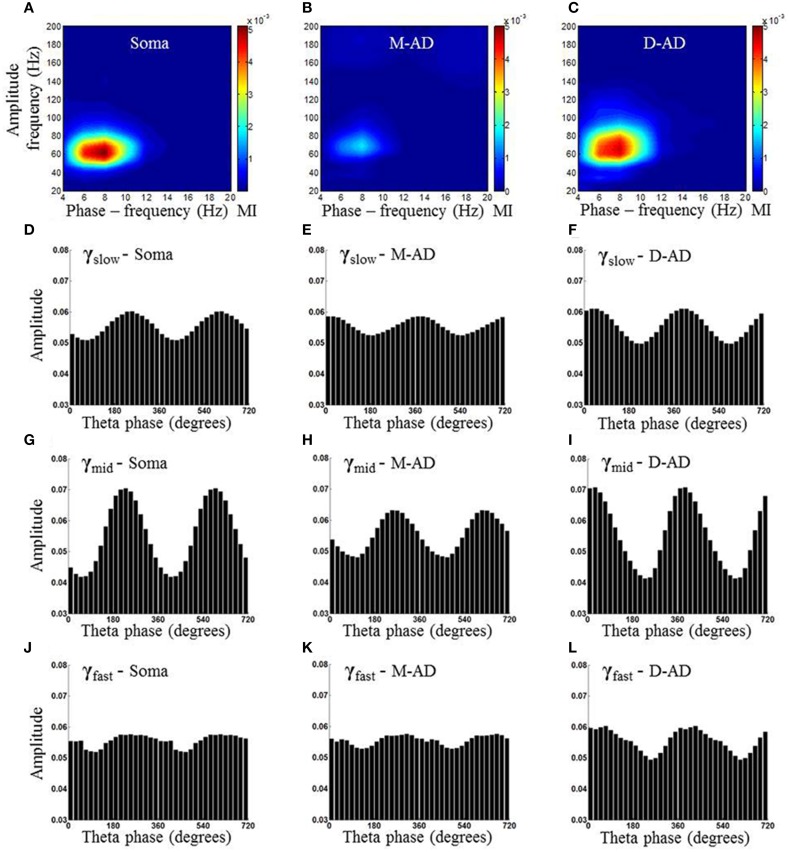
Example of comodulogram and phase amplitude coupling at somatic, mid-apical and distal apical dendrite recording sites, for a single animal. (A–C) Comodulogram showing the modulation Index (MI) plotted as a function of phase-frequency and amplitude-frequency from a single animal. Hotter colors indicate larger amplitude modulation. (D,G,J) γslow (30–45 Hz)/γmid(50–90 Hz) /γfast (90–170 Hz) amplitude modulation by θ (6–10 Hz) phase, binned into 18 subdivisions of 20° each at the somatic recording site. (E,H,K) The γslow, γmid, and γfast amplitudes from the recording site at the mid-apical dendrite (M-AD) shows relative amplitude modulation by θ similar to that seen at the somatic site; however the phase of θ at which gamma amplitude was maximum were offset by 120° for γslow and 20° for γmid. (F,I,L) At the distal apical dendrite (D-AD) the amplitude coupling was anti-phasic (offset by 180°) for γslow and γmid with respect to soma. In addition the θ-γfast coupling was visible primarily only at D-AD [Phase amplitude coupling measurements shown in this figure were obtained from pre-injection baseline data in an exploring animal using the method described by Tort et al. (2010)].